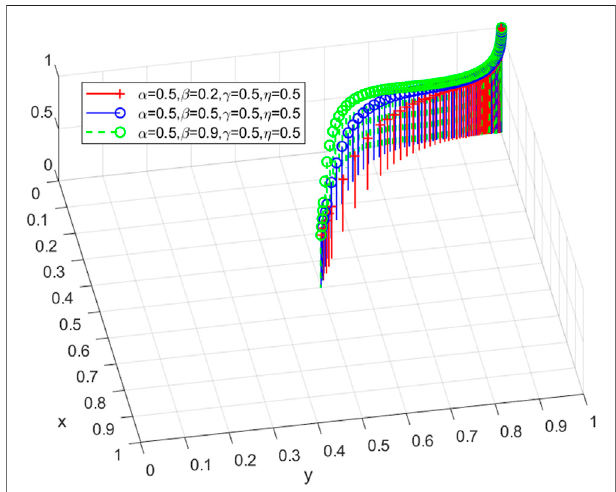
FIGURE 3 | System evolution trajectory under different subsidy intensities β .